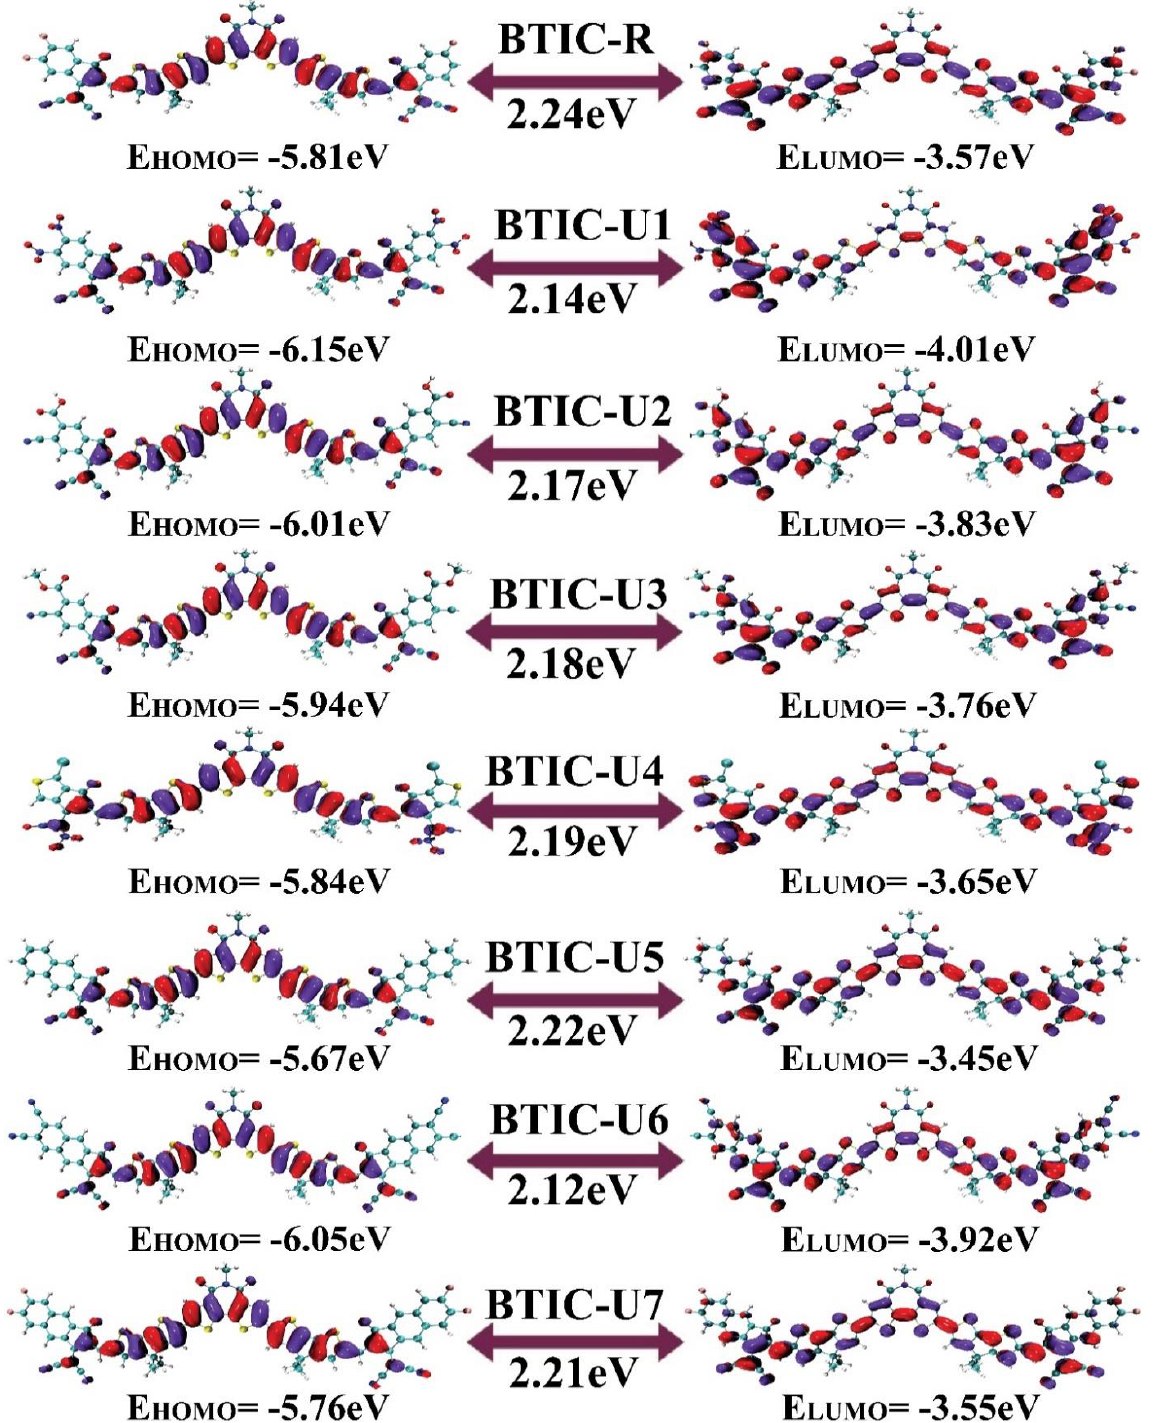
Figure 3. Depiction of FMOs distribution for BTIC − R and BTIC − U1 to BTIC − U7. The HOMO energy of the BTIC-R molecule was measured to be −5 .81 eV, and the LUMO energy of the same molecule was estimated to be −3 .57 eV. This molecule also displayed an E gap of 2.24 eV, which is higher than all proposed compounds. The HOMO of the BTIC-U1 molecule was shown to have the lowest energy of all the molecules stud- ied, which indicates that the HOMO of the BTIC-U1 molecule is the most stable of all the